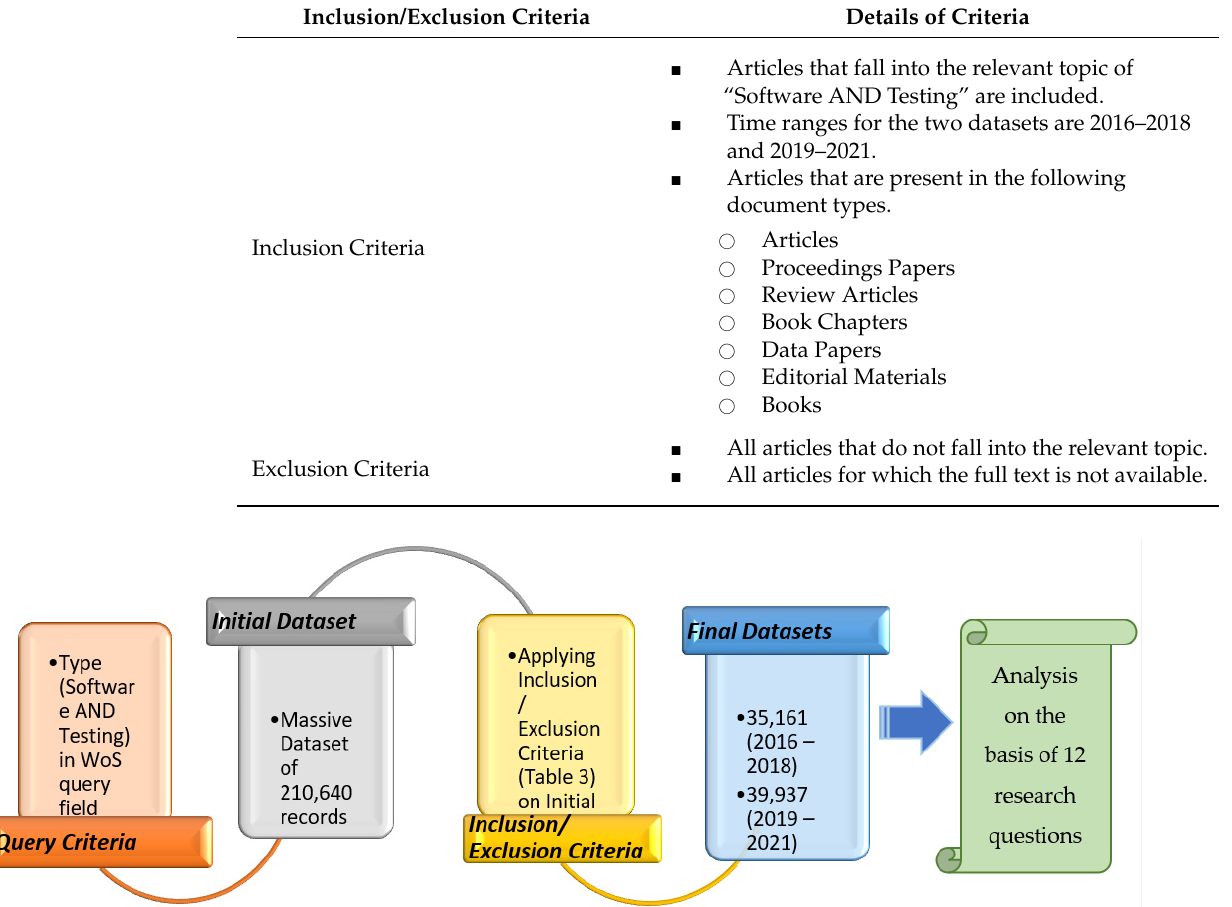
Figure 1. Methodological Process for extracting the two final datasets (2016–2018 and 2019–2021).